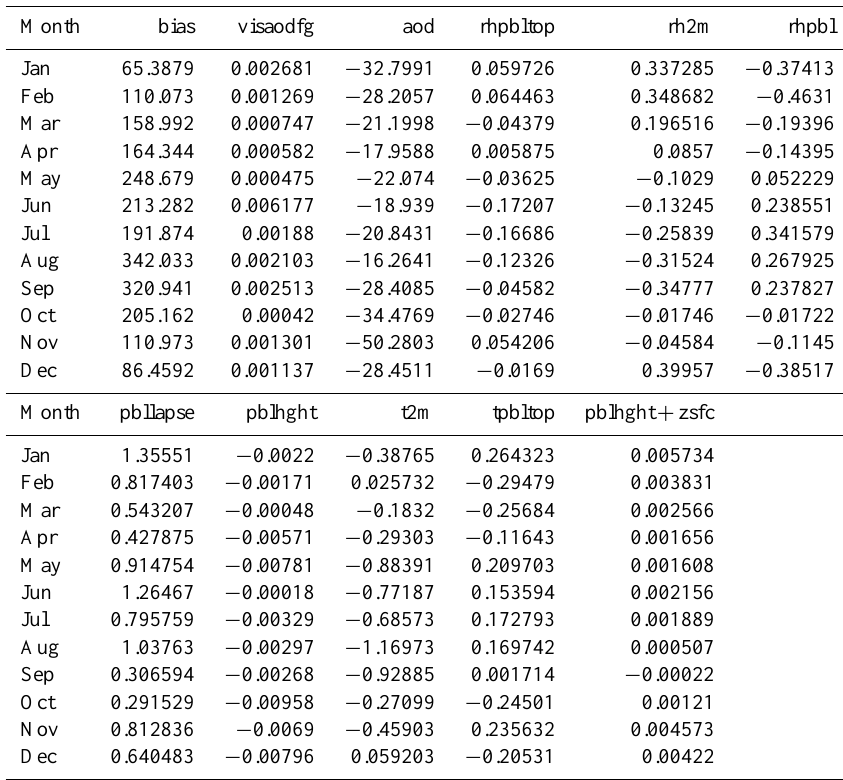
Table 1. Aerosol multiple regression coefficients for bias, first guess aerosol visibility (visaodfg), aerosol optical depth (aod), relative humid- ity at top of the PBL (rhpbltop), 2m relative humidity (rh2m), mean PBL relative humidity (rhpbl), PBL lapse rate (pbllapse), PBL height (pblhght), 2m temperature (t2m), temperature at the top of the PBL (tpbltop), and PBL height plus surface height (pblhght + zsfc) predictors. Regression coefficients for aerosol visibility meteorological